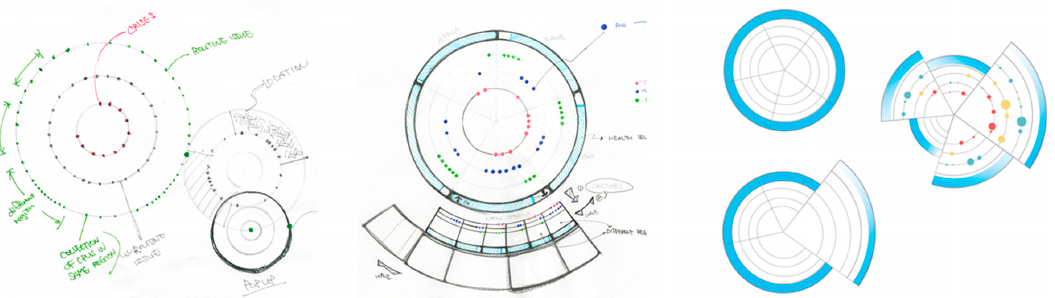
Figure 2 . Design iterations of the circular prototype. Figure 2. Design iterations of the circular prototype.